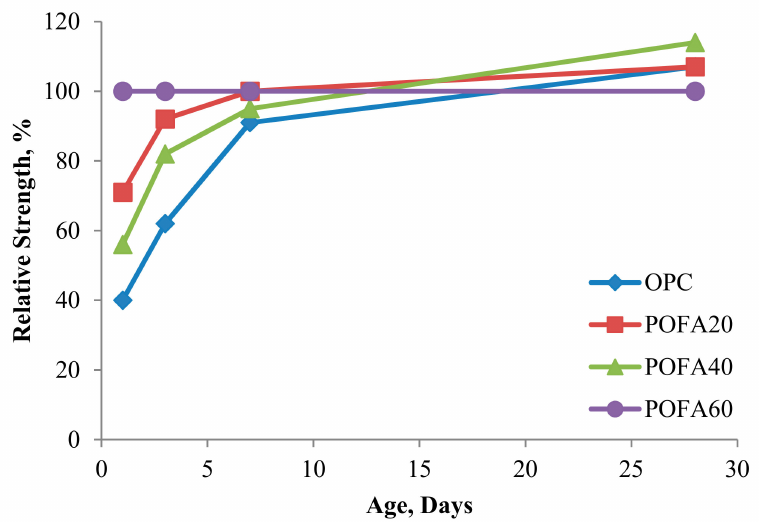
Figure 4. Effect of ultrafine-POFA on the development of compressive strength of high-strength green concrete [56]. Annotations: OPC contains 0% POFA, POFA20—20%, POFA40—40%, POFA60—60%. Reprinted with permission from Elsevier